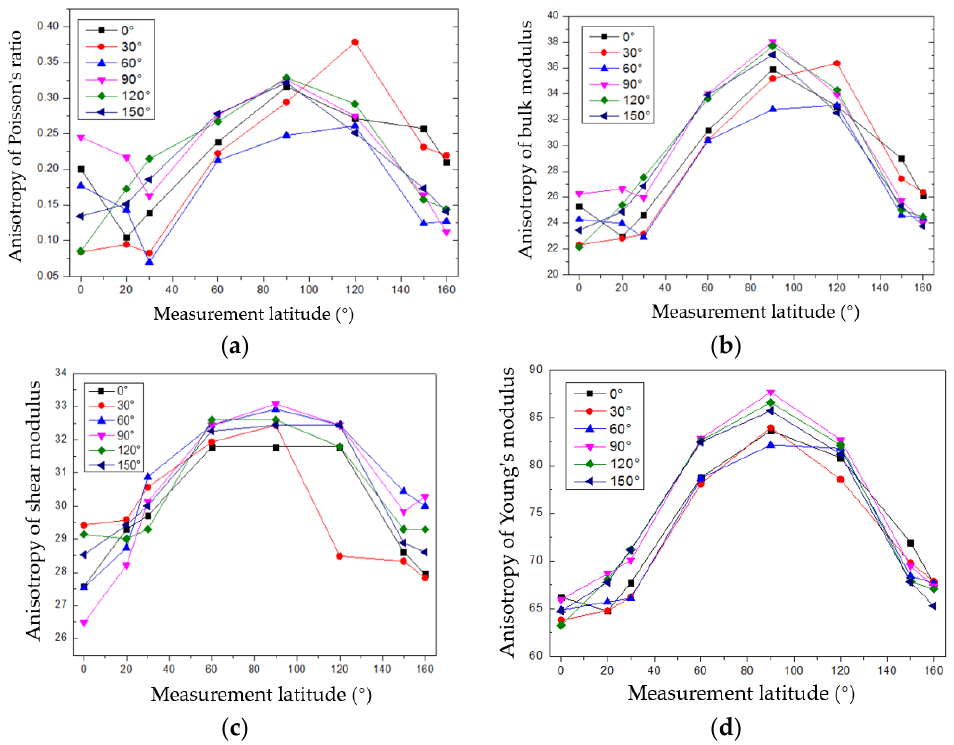
Figure 10. Calculated elastic anisotropic parameters: ( a ) Poisson’s ratio, ( b ) bulk modulus, ( c ) shear modulus, and ( d ) Young’s modulus.